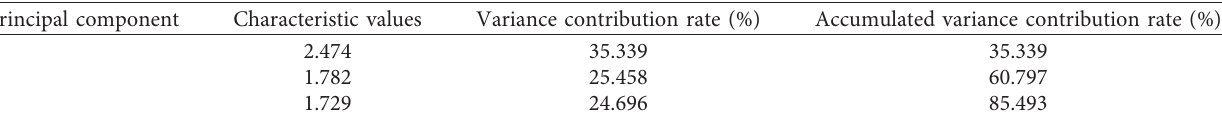
Table 1: Characteristic values and variance contribution rate.